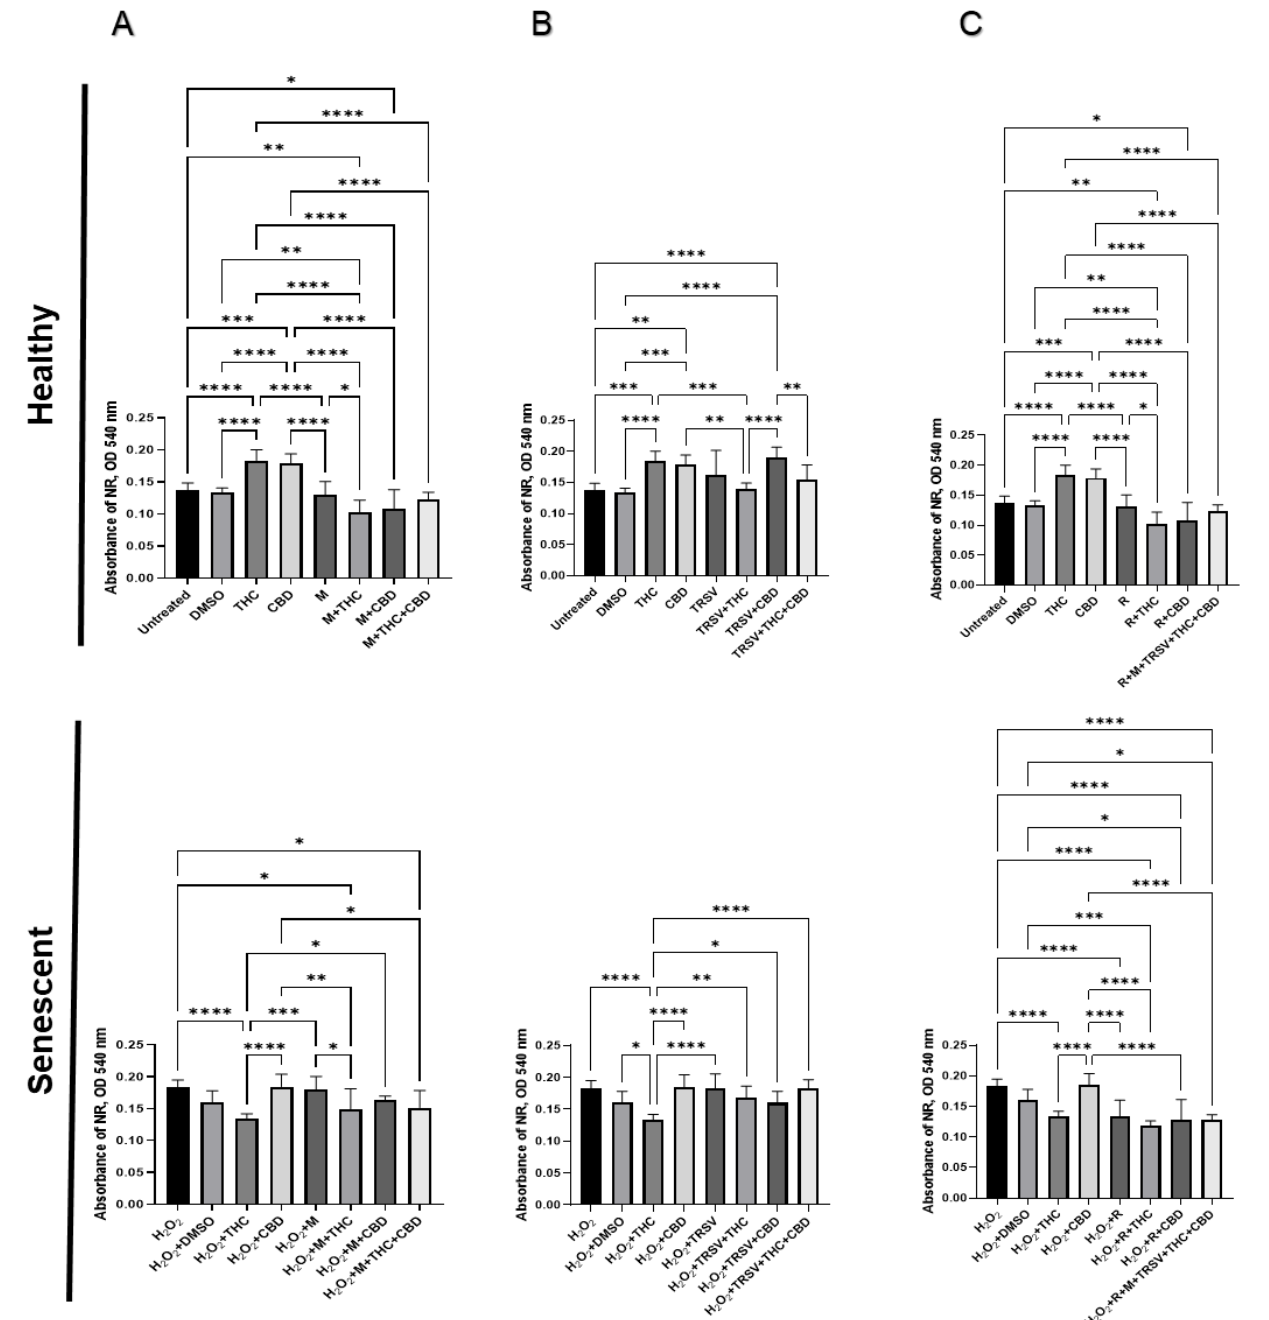
Figure 3. Viability of dermal fibroblasts CCD-1064Sk (p.11) treated with potential anti-aging com- pounds combined with phytocannabinoids. The graphs represent cell viability of skin fibroblasts estimated by NR assay after 72 h of exposure with ( A ) metformin, ( B ) triacetylresveratrol, and ( C ) rapamycin alone or in combination with phytocannabinoids compared to controls and phyto- cannabinoids in both the healthy and senescent state. Data were analyzed with a one-way ANOVA test followed by a Tukey post hoc multiple comparison test. Bars represent mean ± SD. Signifi- cance is indicated within the figures using the following scale: * p < 0.05, ** p < 0.01, *** p < 0.001, **** p < 0.0001. CBD, cannabidiol; DMSO, dimethyl sulfoxide (vehicle), M, metformin; R, rapamycin; THC, ∆ -9-tetrahydrocannabinol; TRSV, triacetylresveratrol.